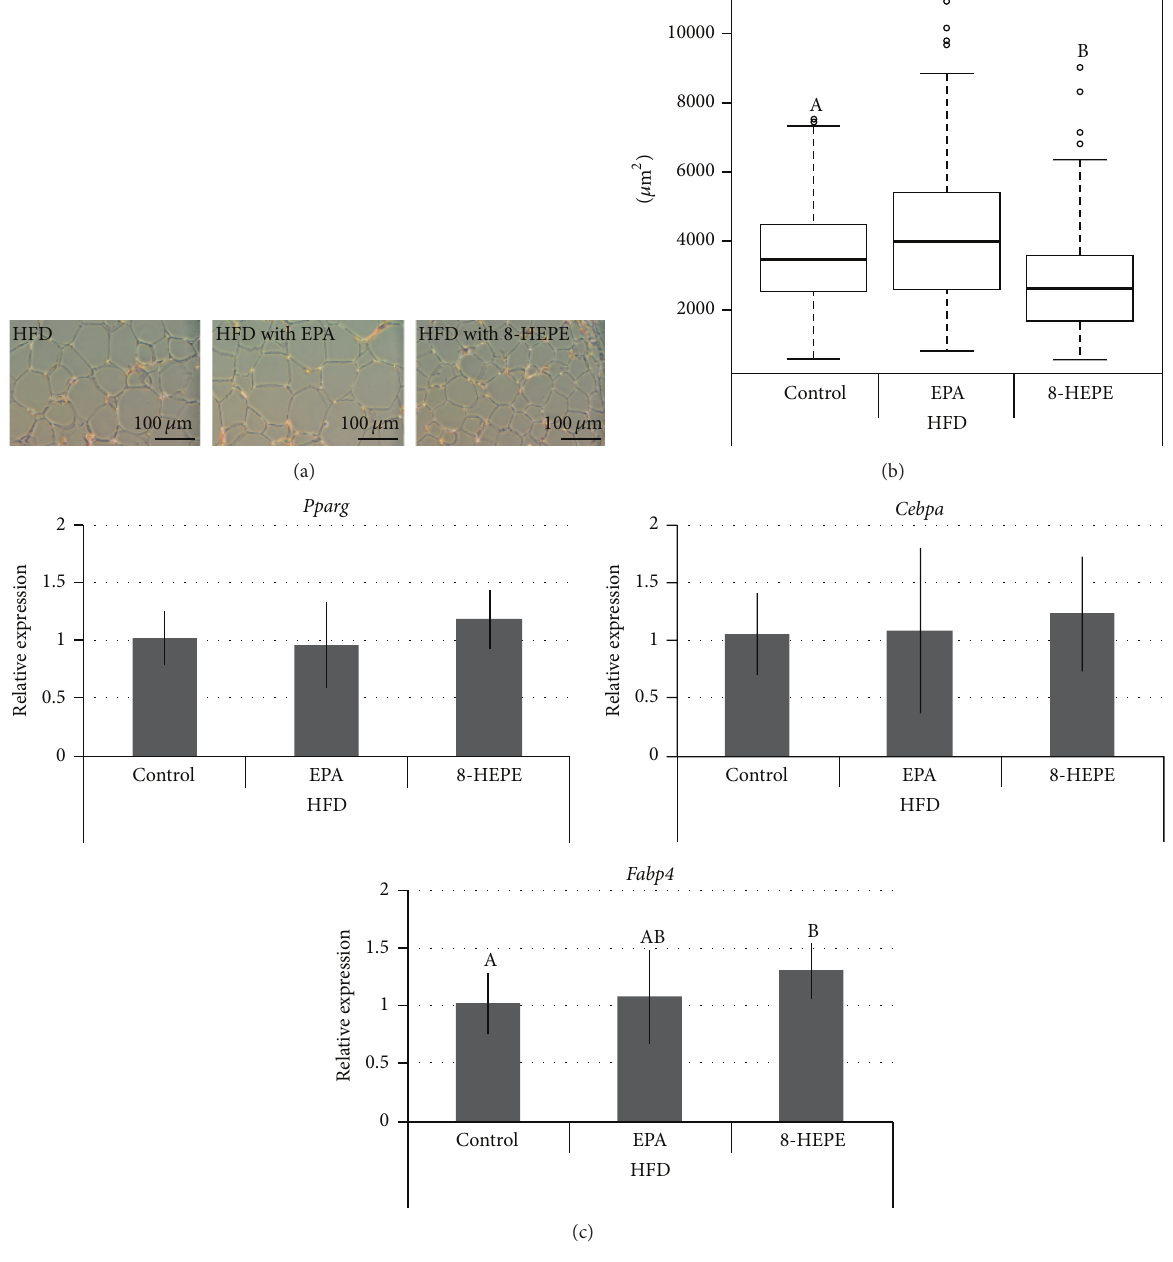
Figure 2: Hematoxylin and eosin staining of gonadal WAT (a), quantification of adipocyte cross sections (b), and expression of Pparg , Cebpa, and Fabp4 in gonadal WAT (c) in male C57BL/6J-DIO mice fed HFD, HFD with EPA, or HFD with 8-HEPE for 4 wk. Data were collected from H&E-stained sections from five mice; two fields of view were analyzed per mouse, and 10–15 cells per field were analyzed using ImageJ software. Gene expression levels were measured by real-time PCR and normalized against expression of Actb . Values are means ± SDs, 𝑛 = 9 . Labeled means without a common letter differ; 𝑃 < 0.05 . HFD: high-fat diet; HEPE: hydroxyeicosapentaenoic acid; EPA: eicosapentaenoic